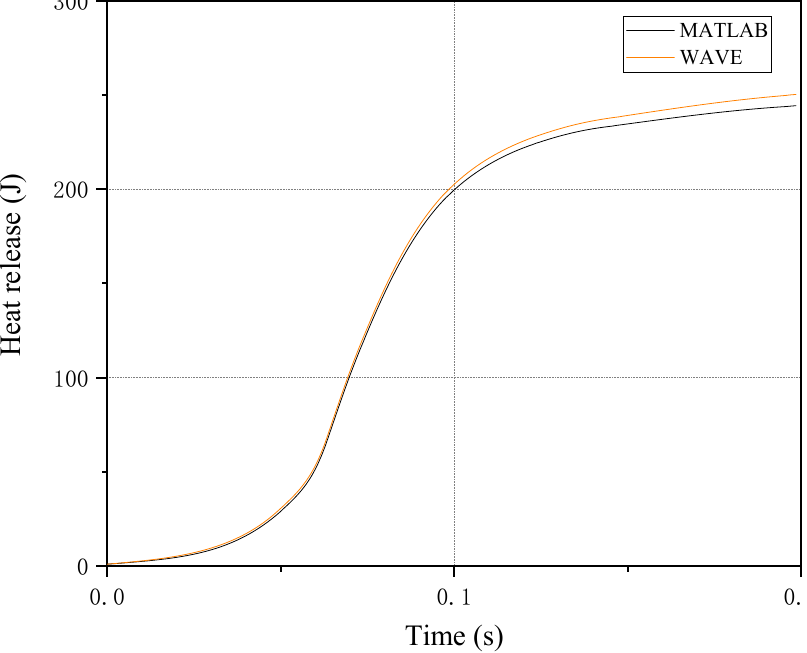
Figure 11. Cumulative heat release comparison between MATLAB and WAVE.